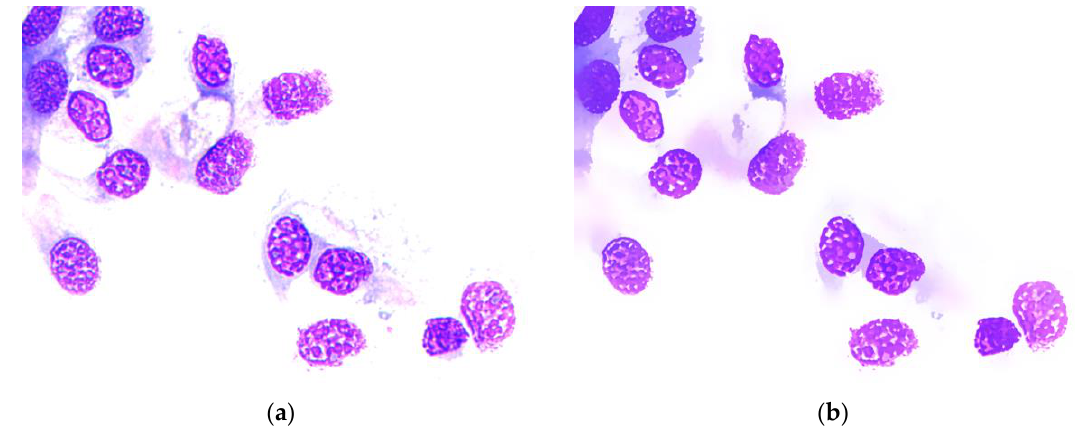
Figure 6. Output images of gamma correction step ( a ) and mean shift ( b ).